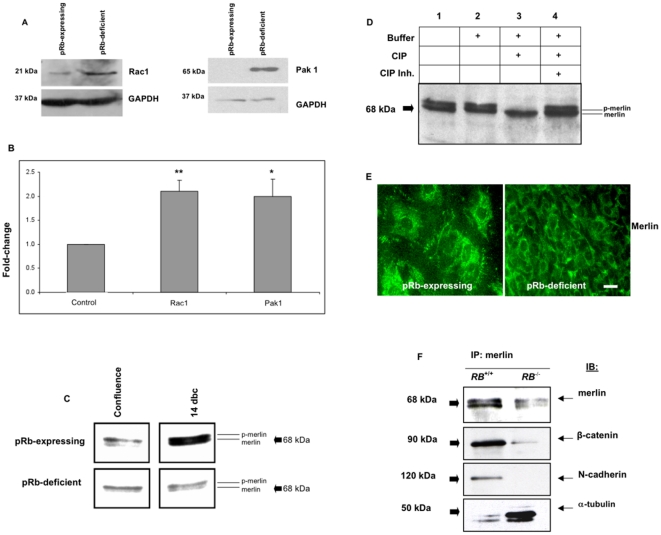
pRb loss results in unregulated Rac1, Pak1, and merlin function.(A) Immunoblot showing increased Rac1 (left) and Pak1 (right) levels in pRb-deficient osteoblasts relative to pRb-expressing controls. Equal loading of lanes is shown by GAPDH levels (bottom panel for each protein). (B) qRT-PCR showing the same upregulation at the mRNA level in pRb-deficient osteoblasts relative to pRb-expressing osteoblasts (control bar). Each bar represents the average of at least 3 independent experiments ± SEM. Values were normalized against GAPDH. **, P<0.005; *, P<0.05. (C) Immunoblot showing an increased ratio of the hypophosphorylated to the hyperphosphorylated merlin in pRb-expressing MC3T3 osteoblasts at 14 dbc. (D) Whole protein extracts from pRb-expressing MC3T3 osteoblasts at 14 dbc treated with calf intestinal phosphatase (CIP) before immunoblot analysis for merlin. CIP treatment eliminated the slower-migrating band, whereas CIP inhibitors reversed this effect. Lane 1, untreated lysates; lane 2, lysates treated only with CIP buffer; lane 3, lysates treated with CIP; lane 4, lysates treated with CIP plus inhibitors. (E) Immunocytochemical localization of merlin in MC3T3 cells. In pRb-expressing MC3T3 osteoblasts merlin staining reveals a strong, punctuated perinuclear pattern as well as a membrane staining (left). In pRb-deficient MC3T3 osteoblasts cells the membrane staining is lost (right). Magnification = ×100. Bar = 1 µm. (F) Merlin was immunoprecipitated from whole protein lysates followed by immunoblots of the immunoprecipitates with antibodies against merlin, β-catenin, N-cadherin, and α-tubulin. In pRb-expressing MC3T3 osteoblasts, merlin is immunoprecipitated predominantly as a hypophosphorylated form together with adherens junction components β-catenin and N-cadherin. In pRb-deficient MC3T3 osteoblasts, merlin is immunoprecipitated predominantly as a hyperphosphorylated form together with α-tubulin.